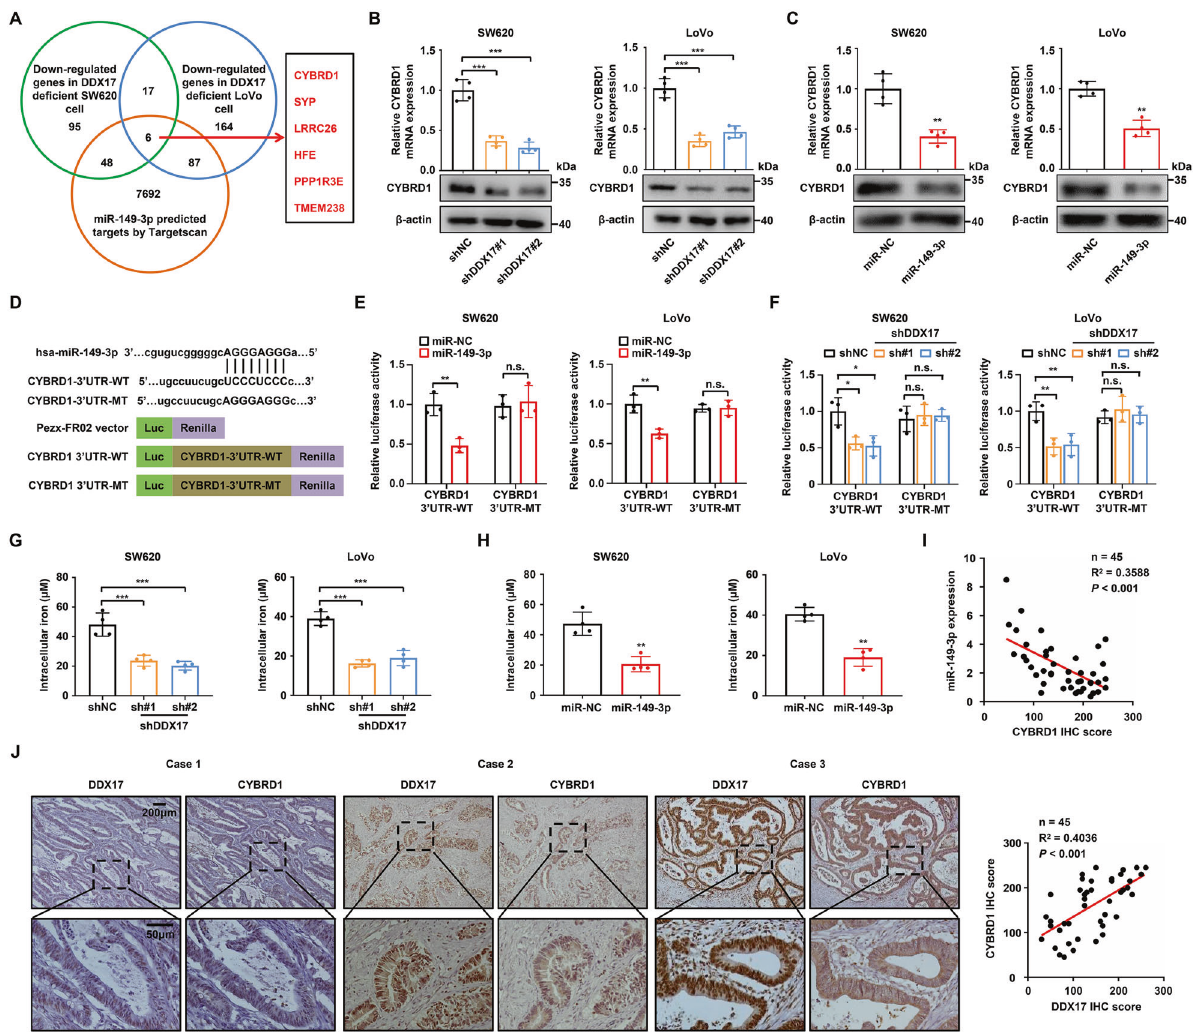
Fig. 5 CYBRD1 is a direct target of miR-149-3p in CRC cells. A Venn diagram shows the number of downregulated genes identi fi ed in response to DDX17 de fi ciency in SW620 (green) and LoVo (blue) cells with a criterion of 1.5-fold change and adjusted p value < 0.05 and predicted miR-149-3p target genes by Targetscan (orange). We identi fi ed six common genes among the three groups (red). B RT ‒ qPCR and western blot analysis examined the effects of DDX17 on CYBRD1 expression in SW620 and LoVo cells. C RT ‒ qPCR and western blot analysis examined the impacts of miR-149-3p on CYBRD1 expression in SW620 and LoVo cells. D The predicted and mutant miR-149-3p binding sequences in the 3 ′ -UTR of CYBRD1 mRNAs were inserted into the PEZx-FR02 luciferase reporter vector. WT and MT represent the wild type and mutant, respectively. E Relative luciferase activity was determined in indicated SW620 and LoVo cells transfected with the wild-type or mutant 3 ′ -UTR of CYBRD1 mRNA. F DDX17-de fi cient SW620 and LoVo cells were transfected with the wild-type or mutant 3 ′ -UTR of CYBRD1 mRNA, and then the relative luciferase activity was determined. G The intracellular iron concentration was examined in DDX17-de fi cient SW620 and LoVo cells. H SW620 and LoVo cells were infected with miR-149-3p lentivirus, and then subjected to an iron assay. I Correlation analysis between CYBRD1 protein expressions and miR-149-3p levels in CRC tissues. J Correlation analysis between the protein expressions of DDX17 and CYBRD1 in CRC tissues. n.s. no signi fi cance, ** P < 0.01, *** P <